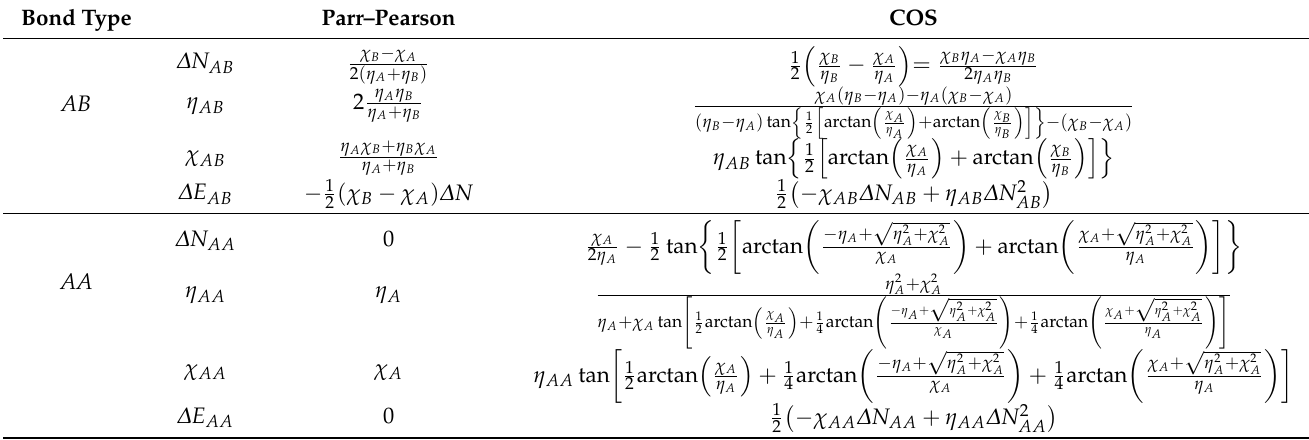
Table 1. The comparison between sensitivity indices (charge transfer, average chemical hardness, average electronegativity and exchanged energy, from the top to the bottom, respectively) for Parr–Pearson and present COS approaches for the main cases of chemical bonds for diatomic molecules: with hetero- and homo- atomic constituents, as provided by Sections 2.2 and 2.3,